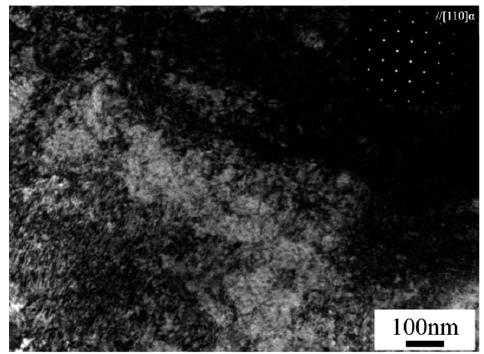
Figure 8. Transmission electron microscope (TEM) bright-field images in the stir zone.